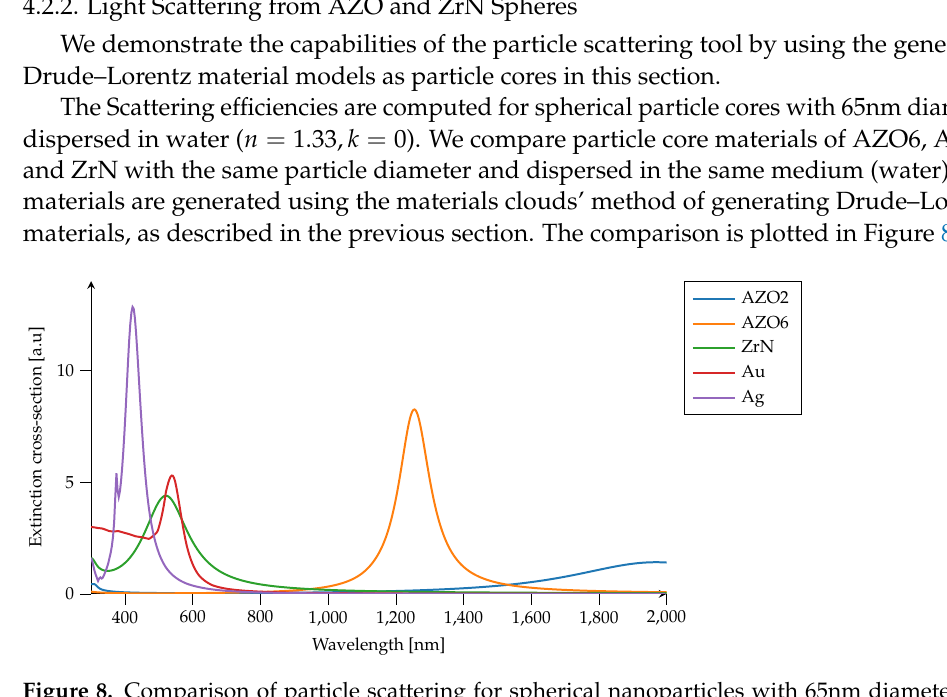
Figure 8. Comparison of particle scattering for spherical nanoparticles with 65nm diameter and dispersed in water with n = 1.33, k = 0. The particle cores are AZO6, AZO2, ZrN, Au [56] and Ag [56], which are generated from materials library for noble metals and using PMCloud’s method of generating Drude–Lorentz materials, described in the previous section. Computed using the materials clouds’ particle scattering